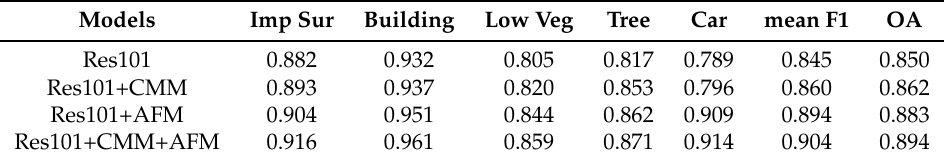
Table 4. Comparison of each module on the metrics of F1 and overall accuracy (OA). Models Imp Sur Building Low Veg Tree